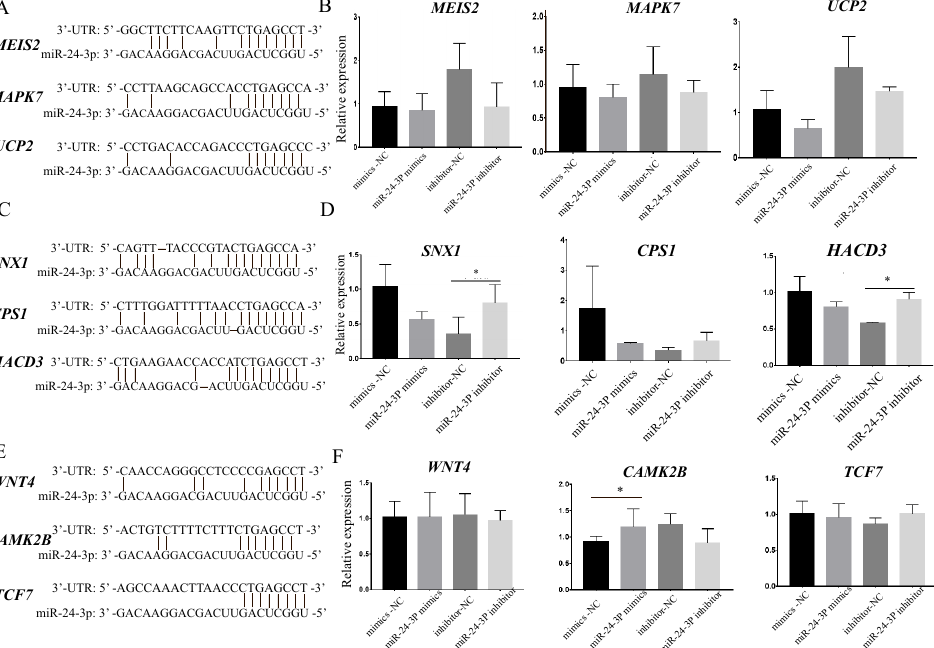
Figure 5. Target gene prediction and their expression profile in miR-24-3p using RT-qPCR in rat and cattle. ( A , B ) The target genes shared by mmu-miR-24-3p in cattle and rat were verified by RT-qPCR. ( C , D ) The specific target genes of mmu-miR-24-3p related to muscle development were verified by RT-qPCR. ( E , F ) The target genes shared by bta-miR-24-3p in cattle and rat were verified by RT-qPCR. mmu-miR-24-3p indicates rat miR-24-3p; bta-miR-24-3p indicates cattle miR-24-3p. * p <